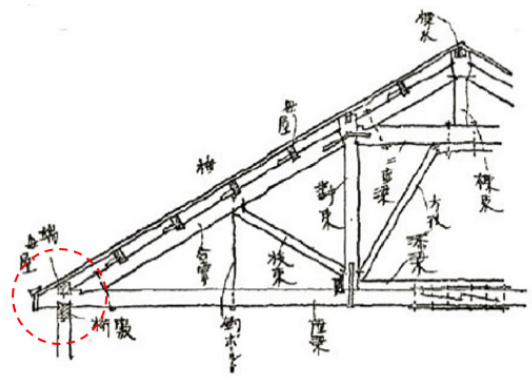
Figure 10. A roof truss with overhang [17].